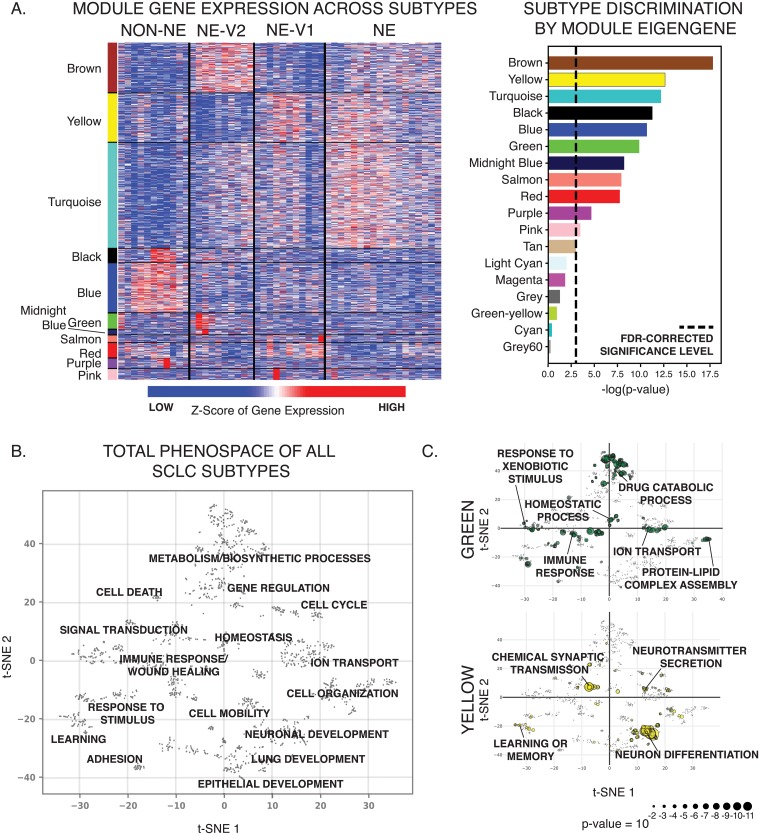
SCLC subtypes can be distinguished by gene expression patterns.A. Transcriptional patterns that distinguish the four subtypes are captured in WGCNA analysis. Gene modules by color show patterns of expression that are consistent across the subtypes. Only modules that significantly distinguish between the subtypes are shown (ANOVA, FDR-corrected p-value < 0.05). B. SCLC heterogeneity biological process phenospace. A dissimilarity score between pairs of SCLC-enriched GO terms was calculated using GoSemSim, and used to create a t-SNE projection grouping similar biological processes together. Several distinct clusters of related processes can be seen. C. Module-specific phenospace. A breakdown of where some of the 11 statistically significant WGCNA modules fall in the GO space from A. Of particular interest, the green module, which is highly upregulated in the NEv2 phenotype, is enriched in metabolic ontologies, including drug catabolism and metabolism and xenobotic metabolism. The yellow module is enriched in canonical neuronal features.